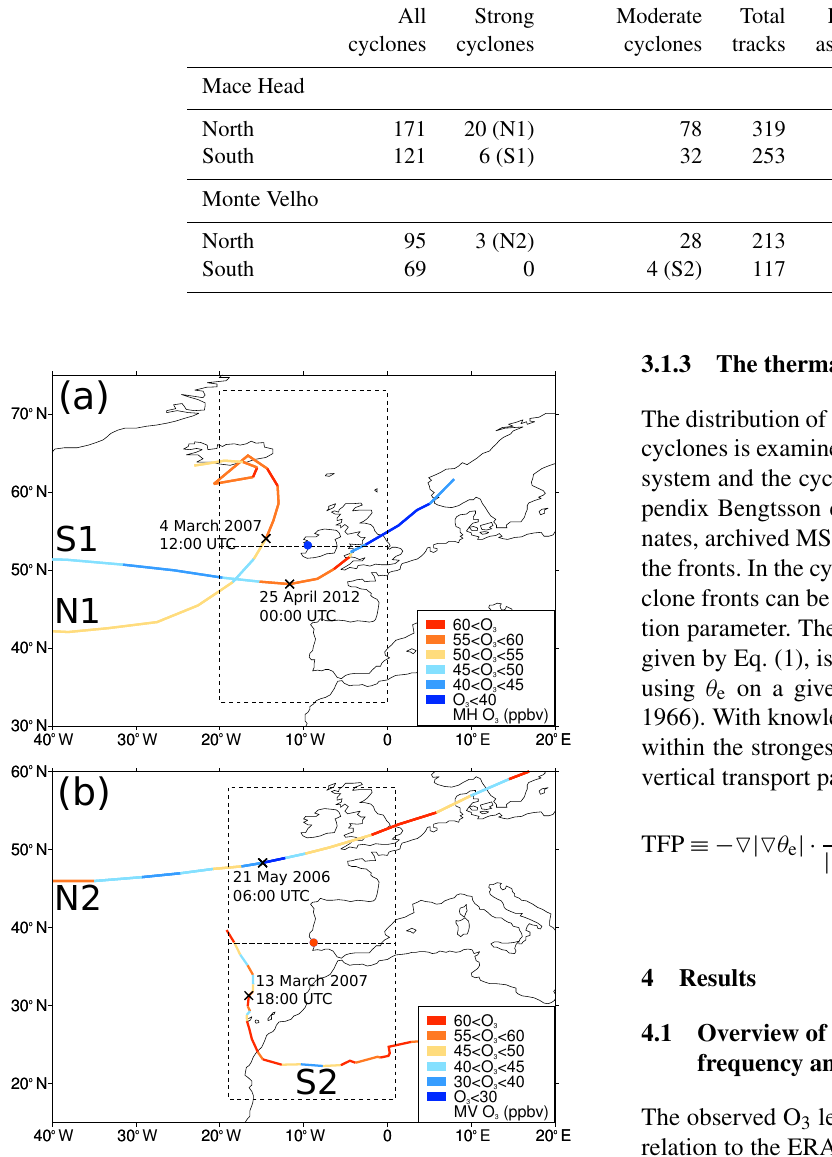
Table 1. The number of cyclones by strength (where strong cyclones and moderate cyclones are a subset of all cyclones) from the MACC reanalysis associated with high 6-hourly averaged O 3 observations at Mace Head for the period 2003–2012 and at Monte Velho for the period 2003–2009 (exclusive of 2005) using the 6-hourly averaged O 3 pc values. The case study cyclones are included in the respective category. Number of cyclones (by strength) asso- ciated with high O 3 (O 3 > 75th pc)